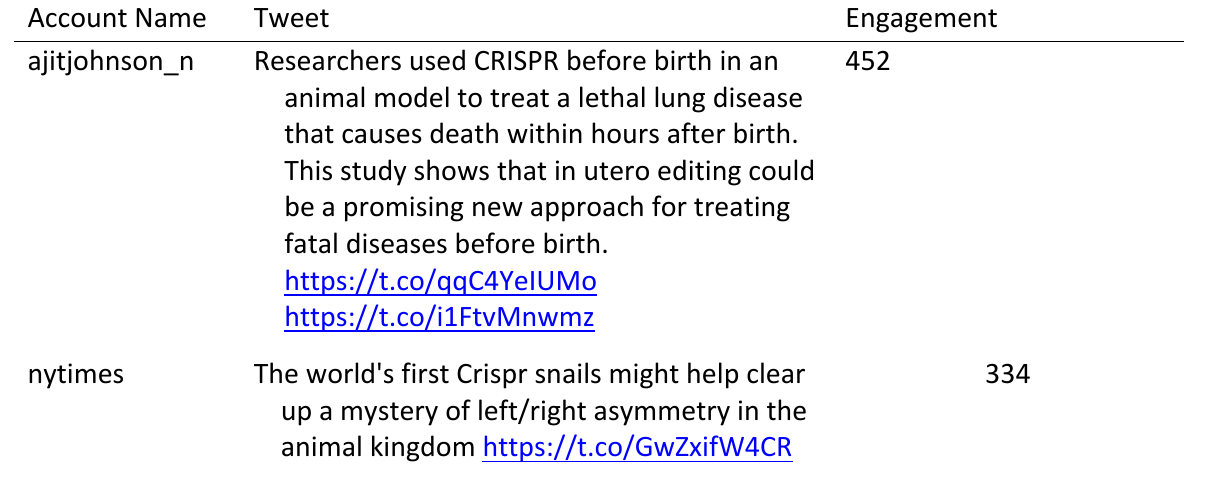
Gene Editing in Agriculture Top 10 Twitter Posts Regarding